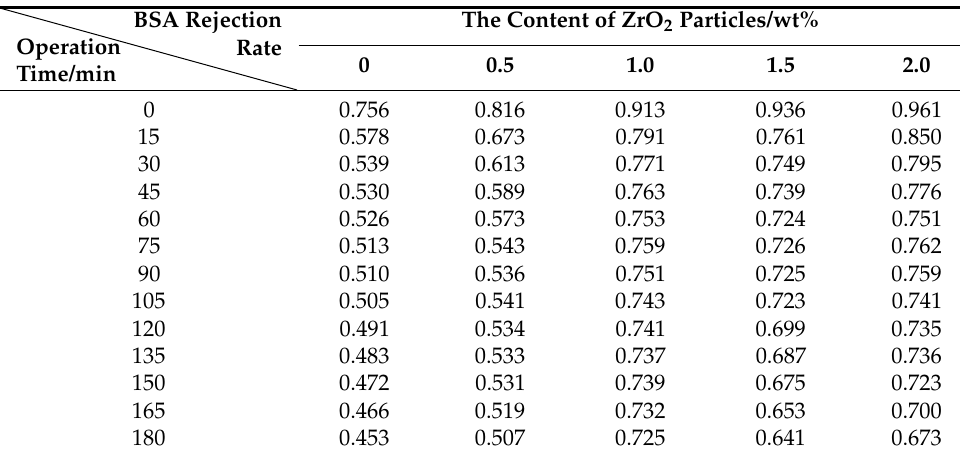
Figure 5. The impact of running time on membrane rejection performance. Table 1. Changes of BSA separation efficiency under different ZrO 2 content.